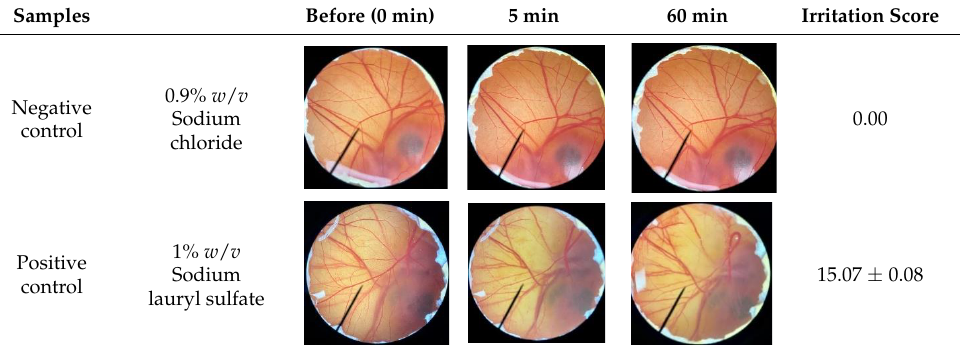
Table 5. Effect of 1% w / v sodium lauryl sulfate solution (positive control), 0.9% w / v sodium chloride solution (negative control), and antler-type G. lucidum BG on hen’s egg chorioallantoic membrane before (0 min) and after exposure for 5 and 60 min.